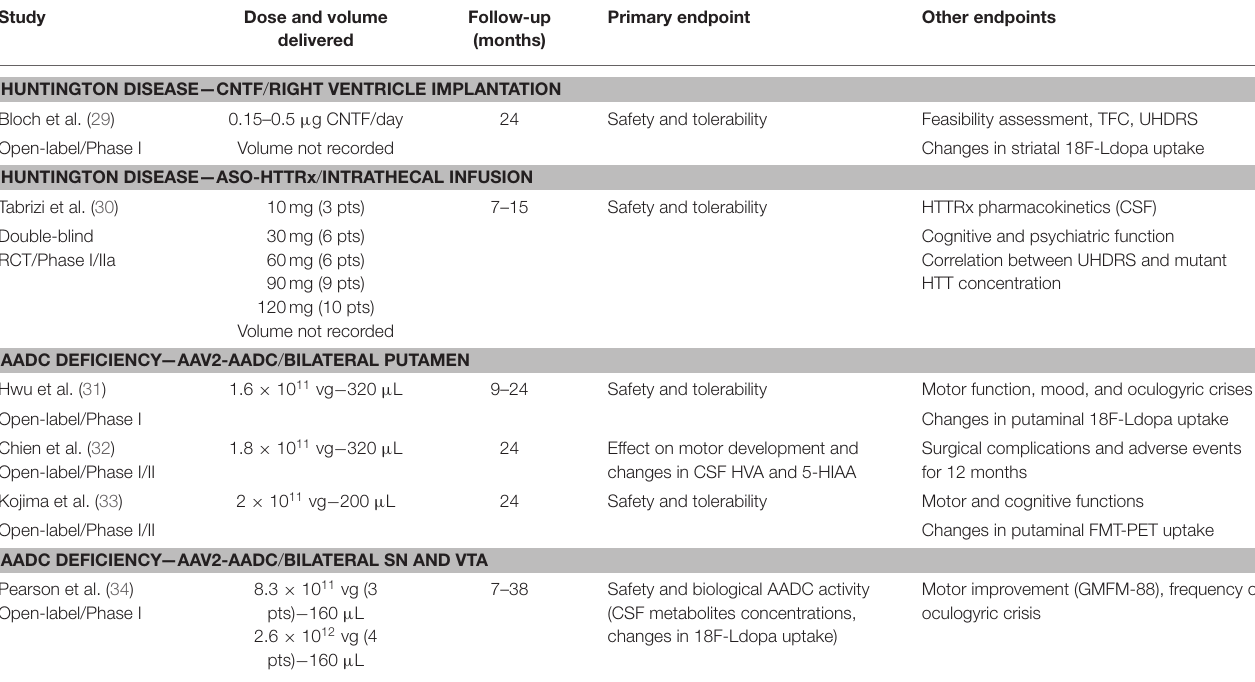
TABLE 5 | Reviewed articles—sample characteristics and endpoints—other diseases. Study Dose and volume Follow-up Primary endpoint Other endpoints delivered (months) HUNTINGTON DISEASE—CNTF / RIGHT VENTRICLE IMPLANTATION Bloch et al. (29) Safety and tolerability Feasibility assessment, TFC,